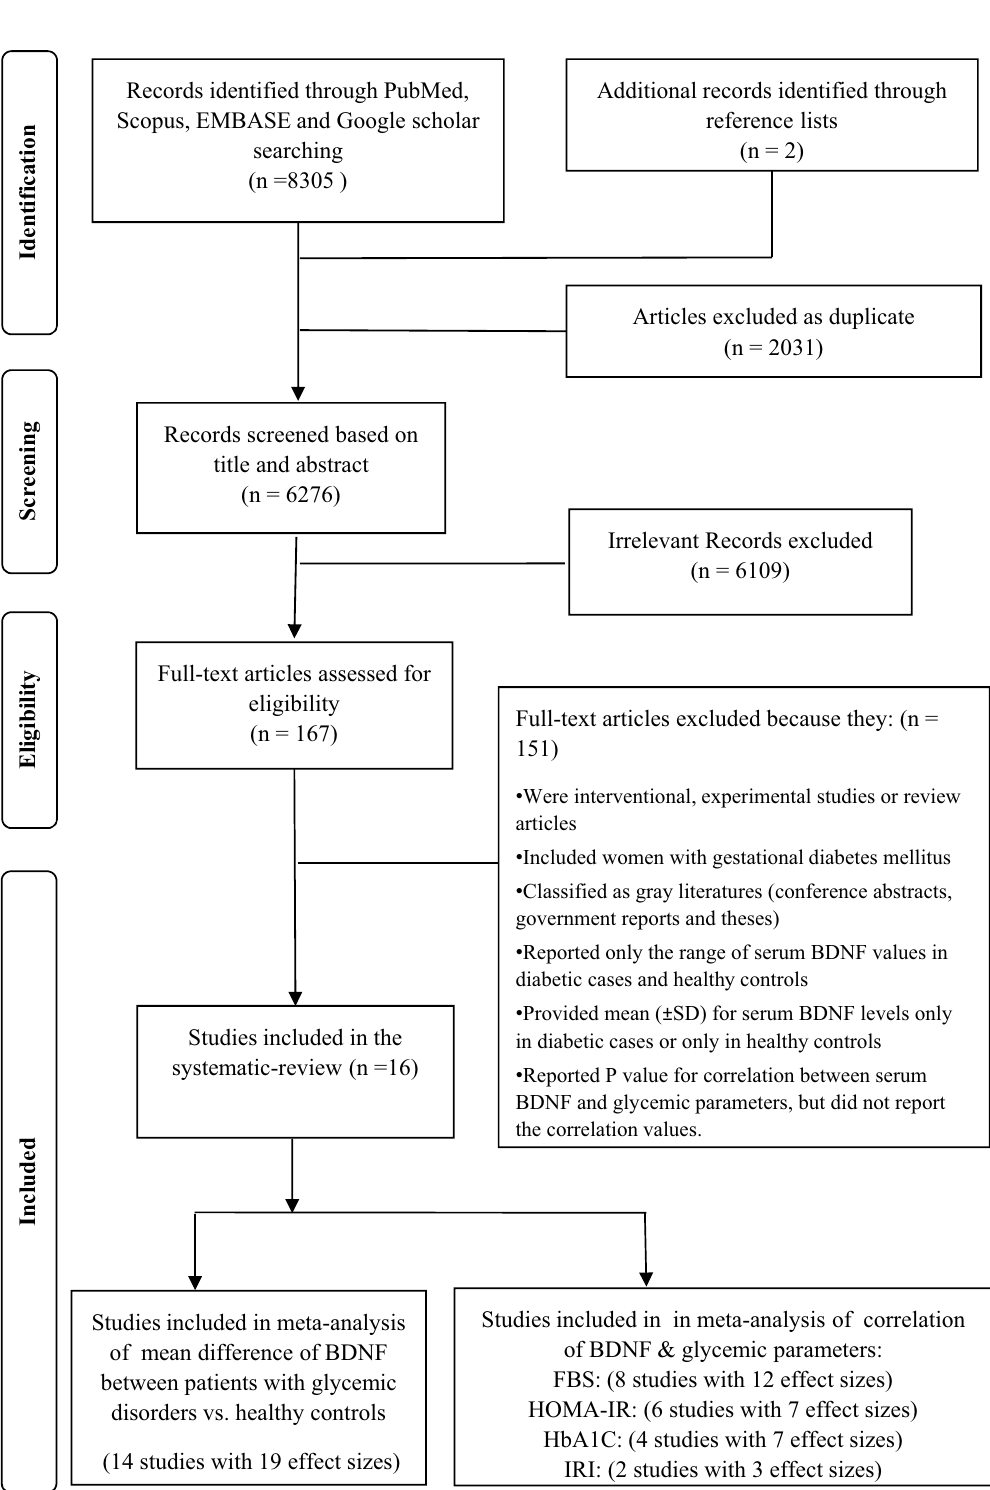
Figure 1. Flowchart diagram describing the process of study